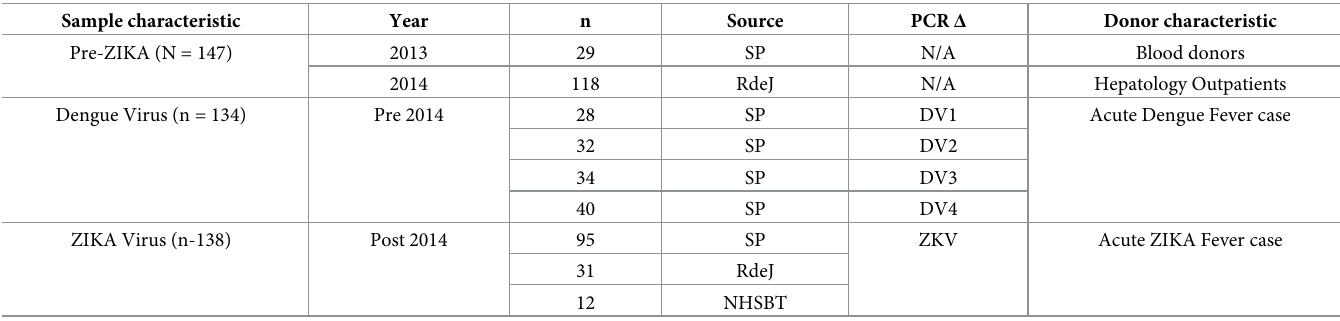
Table 1. Sample and donor characteristics.